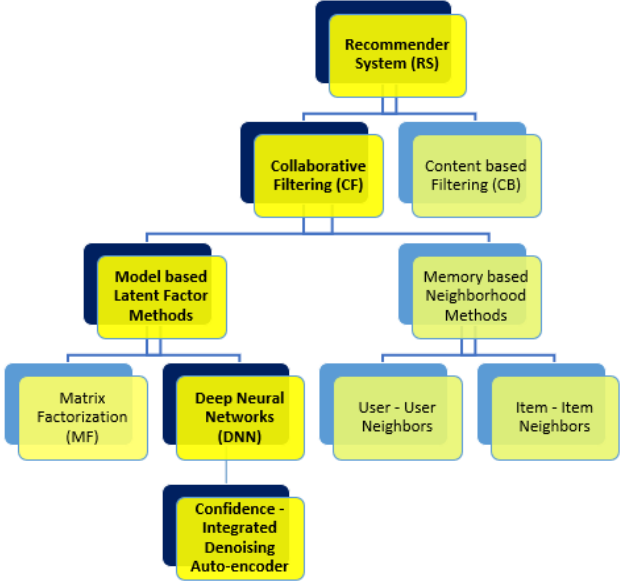
Figure 1. Hierarchical flow of the research problem.